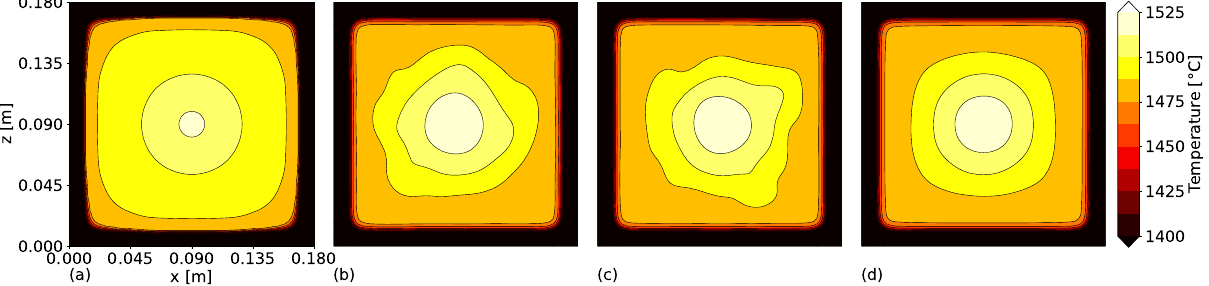
Figure 6. Temperature field at HA1. ( a ) k − ε model; steady-state; ( b ) Large-eddy simulation (LES) model at t 1 = 205 s; ( c ) LES model at t 2 = 1096 s; ( d ) LES model;